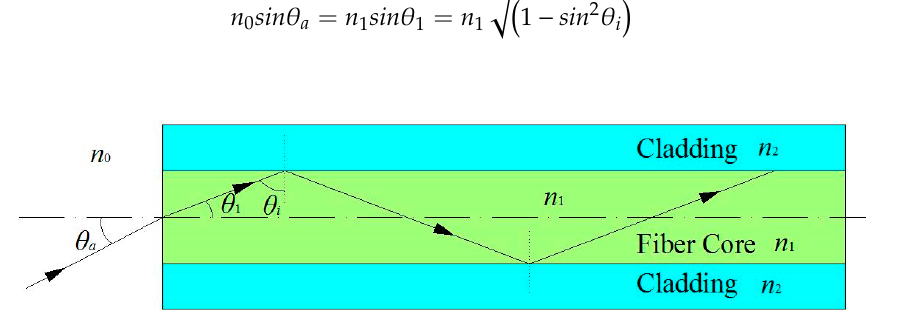
( a ) view from the indoor side; ( b ) view from the indoor side; ( c ) illumination of the TCP.